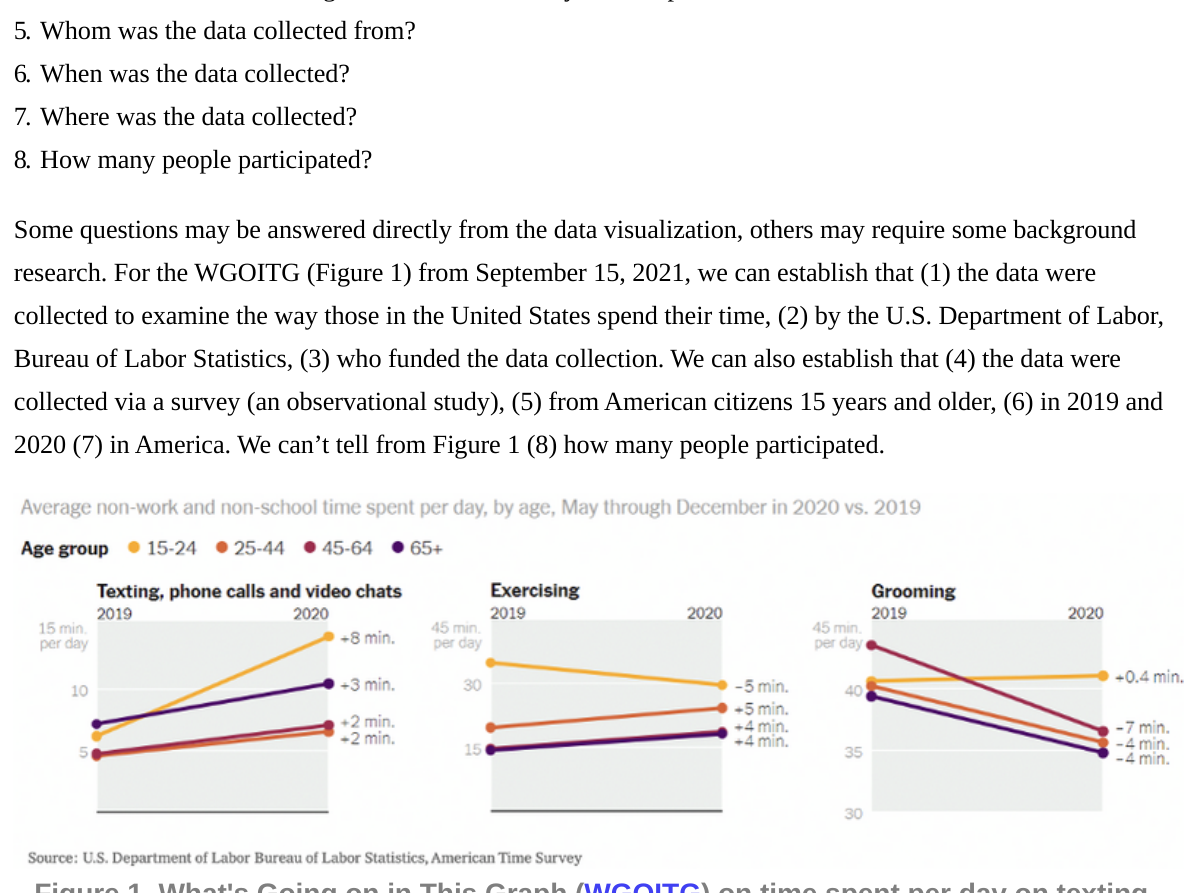
Figure 1. What's Going on in This Graph (WGOITG) on time spent per day on texting, phone calls, and video chats, exercising, and grooming. The data visualizations compare time spent for 2019 with time spent for